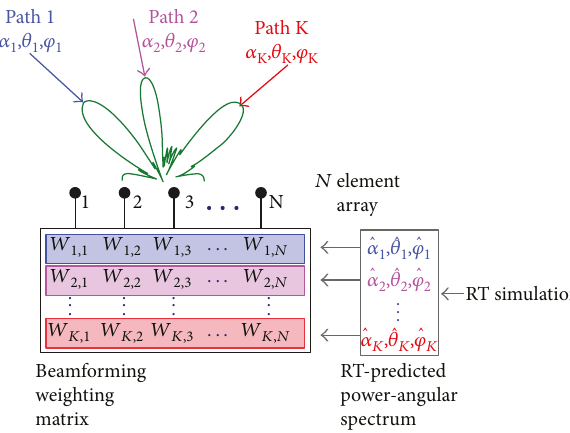
Figure 1: An illustration of the RT-assisted beamforming principle. The spatial channel consists of K paths, with its k th path characterized by its amplitude α angle θ with k ∈ 1, K k